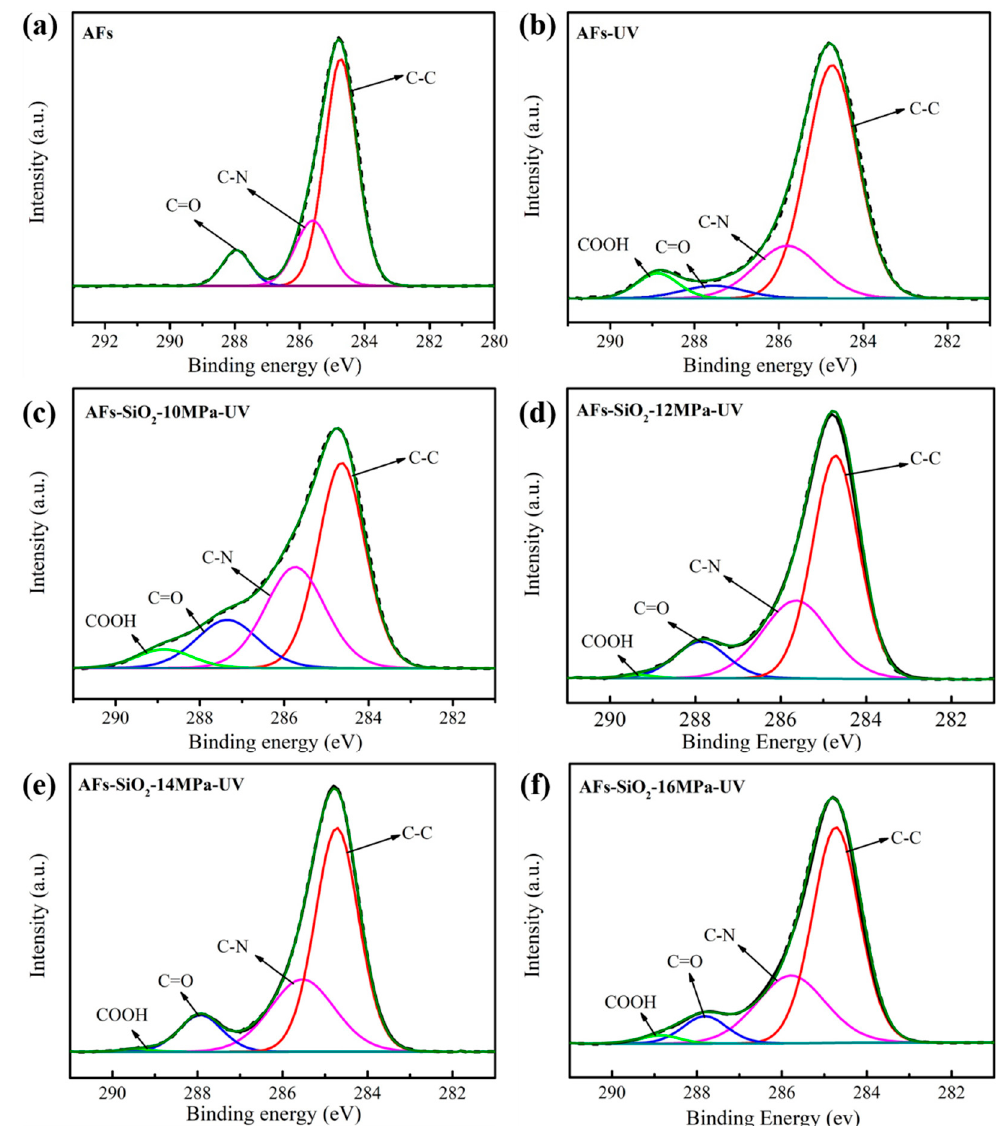
Figure 10. C1s core-level spectra of AFs and irradiated AFs.